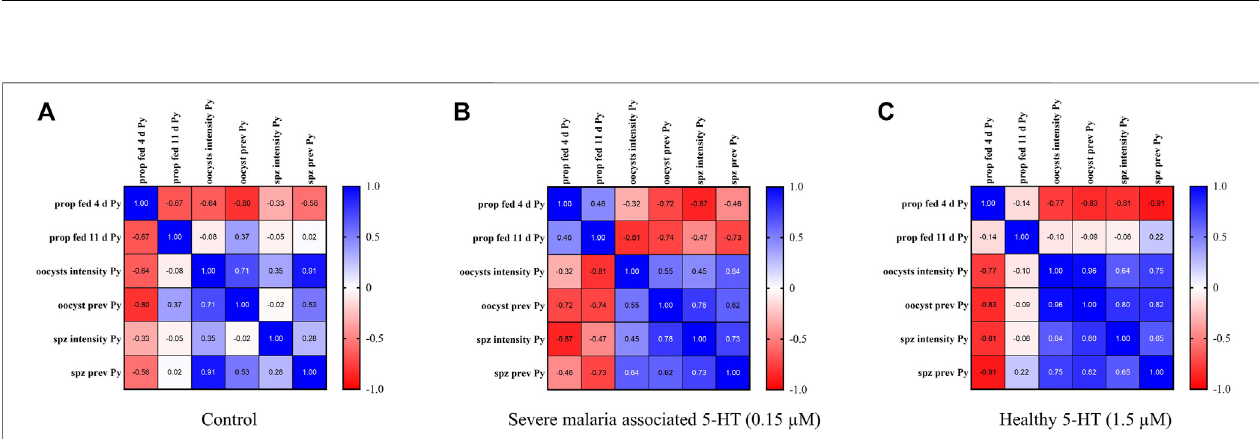
FIGURE9| Correlationmatricesofdatafrom A.stephensi infectedwith P.yoeliiyoelii 17XNLfollowingprimingfor3 dayswith5-HTorwater(control)soakedcotton balls. (A) Correlation matrix of data from mosquitoes treated with water (control). (B) Correlation matrix of data from mosquitoes treated with severe malaria associated levels of 5-HT (0.15 µM). (C) Correlation matrix of data from mosquitoes treated with healthy 5-HT concentrations (1.5 µM). N = 6; Procrustes analysis. *control vs. 1.5 µM, p = 0.0198, *0.15 µM vs. 1.5 µM, p = 0.0460.